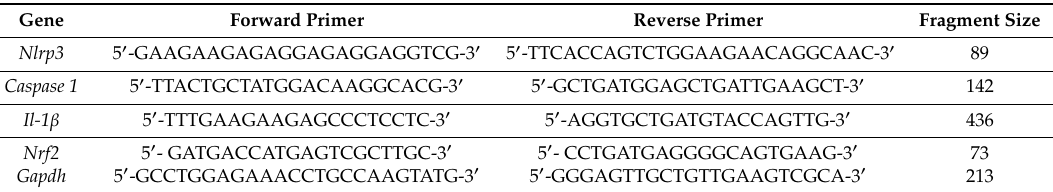
Table 2. Real-time PCR